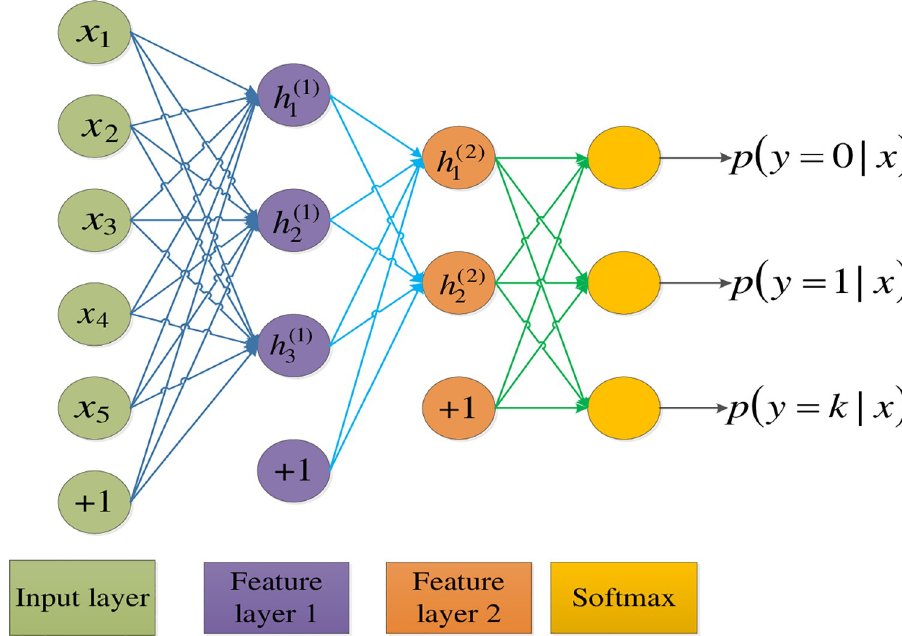
Fig 8. The structure of the Softmax regression machine learning